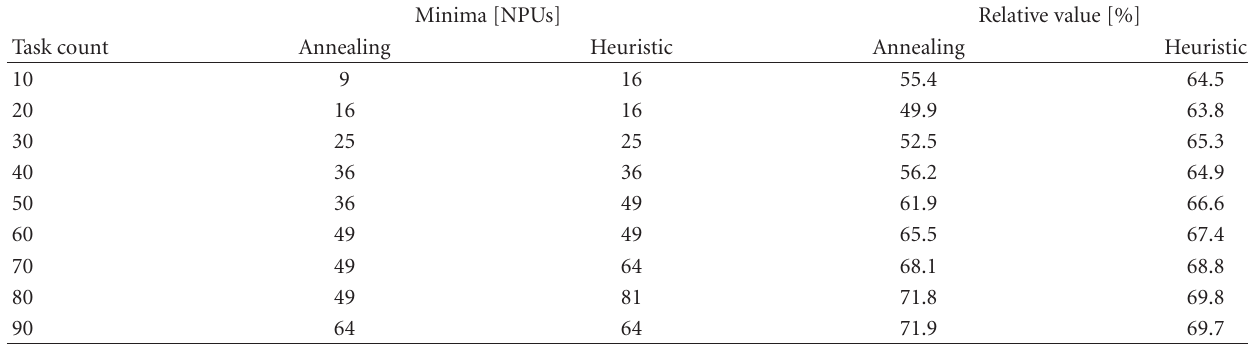
Table 6: Relative OF-minima (values in % of random